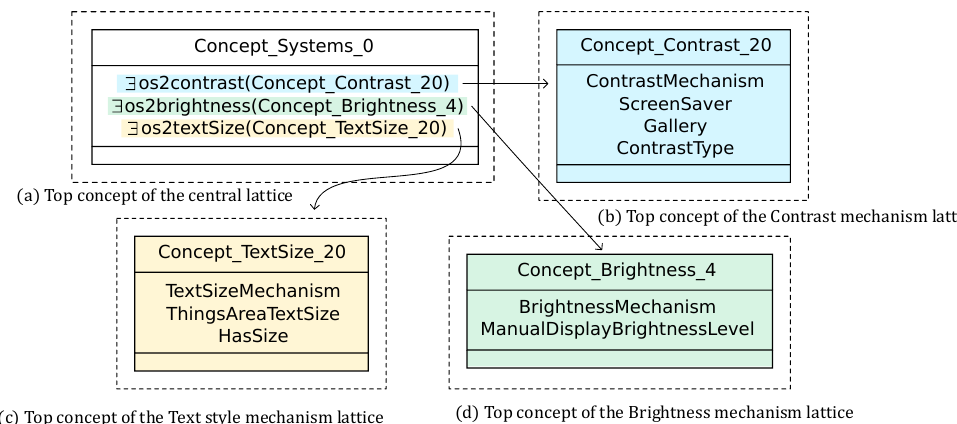
Figure 9. Top concepts of the different concept lattices (redrawn from the lattices output of the tool for the sake of